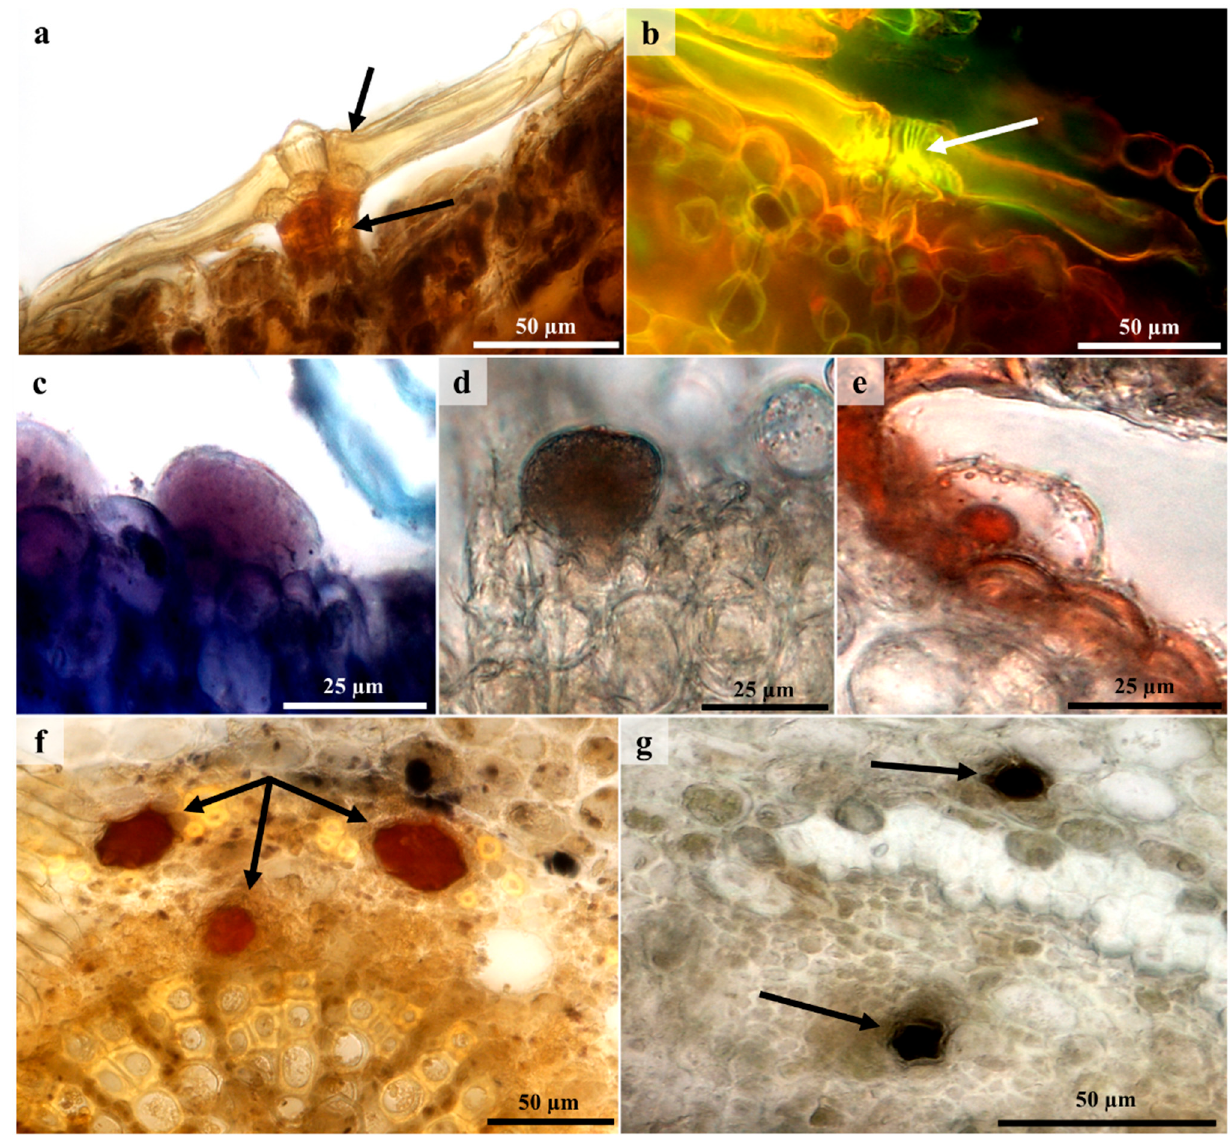
Figure 8. Histochemical and fluorescence micrographs showing chemical compounds of lepidote and glandular trichomes, and laticifers. ( a ) Orange/brown coloration of stalk (intense) suggests a positive indication for the presence of alkaloids with Wagner’s reagent. ( b ) Yellow fluorescence with acridine orange revealed lignified central cells in lepidote trichomes. ( c ) Pink coloration inside glandular trichome indicated neutral lipids with Nile Blue. ( d ) Glandular trichomes tested positive for phenolic compounds with ferric chloride (indicated by brown/black precipitate). ( e ) Lipid droplet of glandular trichome stained red/orange with Sudan III. ( f ) Orange coloration of laticiferous cells is a positive indication for alkaloids with Wagner’s reagent. ( g ) Positive indication (dark brown to black) for phenolic compounds in laticiferous cells stained with ferric chloride. Arrows – Positive reactions for stains. Table 1. Histochemical analysis of lepidote trichomes (LT), glandular trichomes (GT), and laticifers (L) of C. gratissimus var. gratissimus .